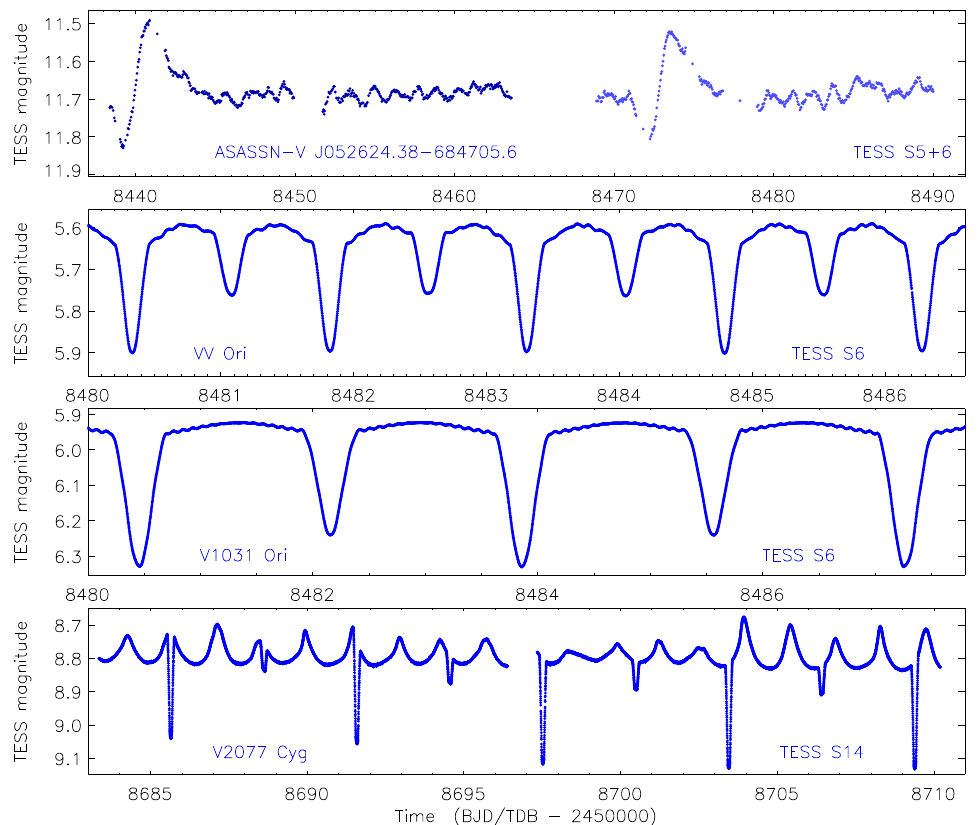
Figure 8. Example TESS light curves of binary stars containing pulsating stars. The names and sectors are